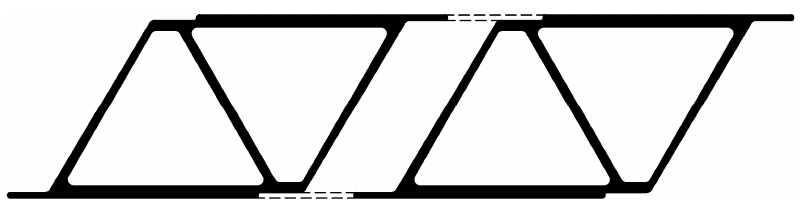
Figure 5. ASSET FRP deck, based on [47].